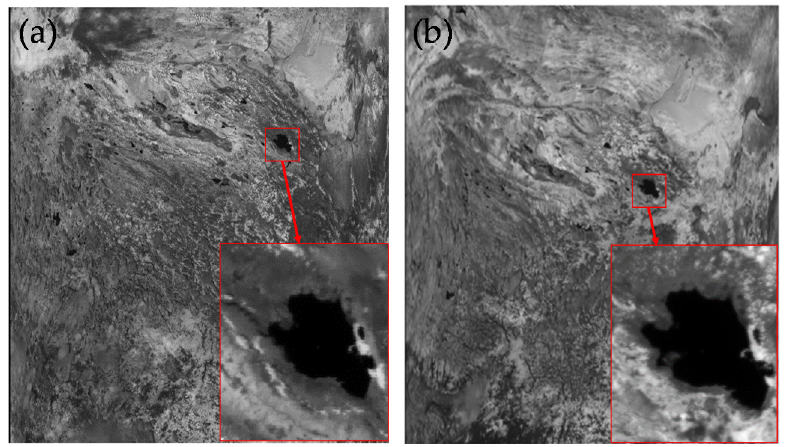
Figure 11. Satellite images: ( a ) 14:38 (UTC + 08:00), 18 August 2018; ( b ) 14:43 (UTC + 08:00), 23 August